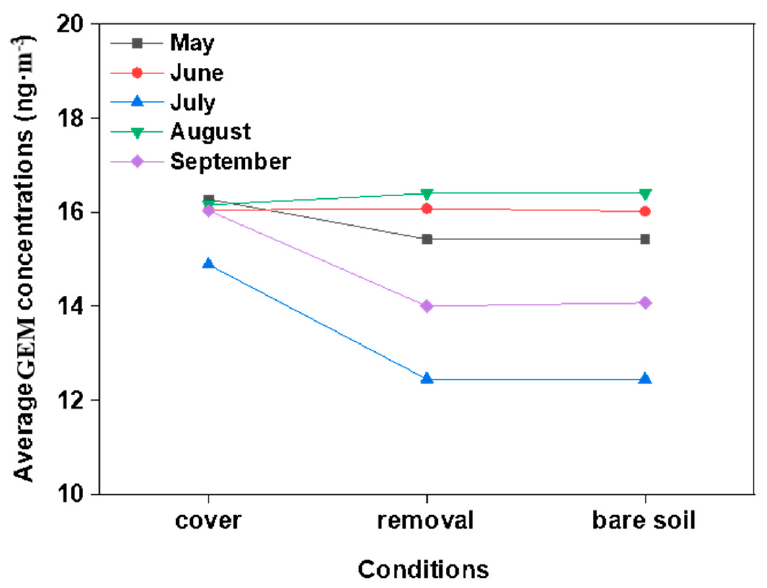
Figure 6. Twenty-four-hour average GEM concentrations under the three examined conditions during the monitored seasons.